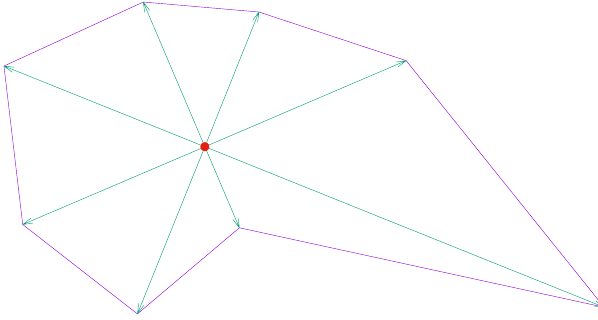
Figure 6. Boundary exploration in one crossection Figure 7. Boundary exploration in one